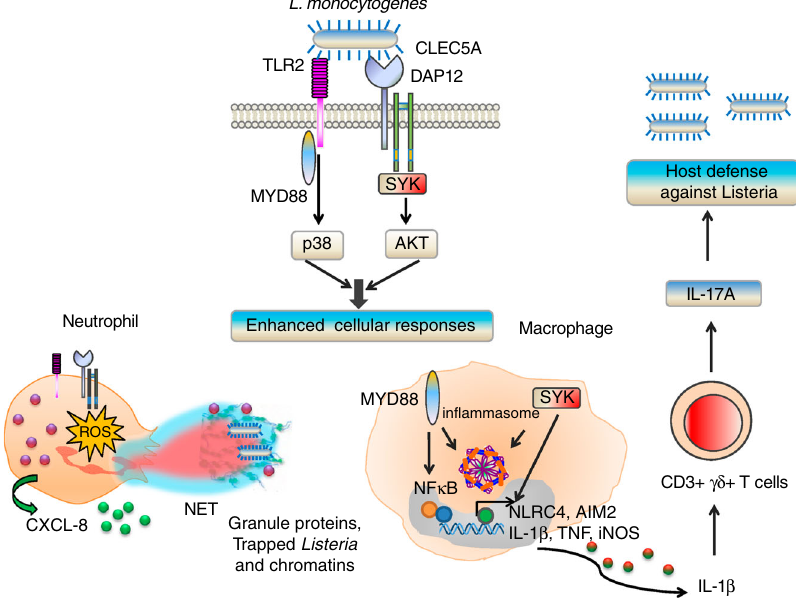
Fig. 7 Co-activation of CLEC5A and TLR2 by L. monocytogenes enhances host immunity. Listeria activates CLEC5A and TLR2 simultaneously to activate both MyD88-p38 and Syk-AKT signaling pathways. Co-activation of CLEC5A and TLR2 in neutrophils enhances CXCL8 and ROS production, and NET formation, whereas co-activation of CLEC5A and TLR2 in macrophages induces in fl ammasome activation and production of IL-1 β to stimulate the development of IL-17A proudcing TCR γδ − / − − / − − / − − / − Clec5a : 28.7%, Tlr2 : 23.2%, and Clec5a Tlr2 : 33%